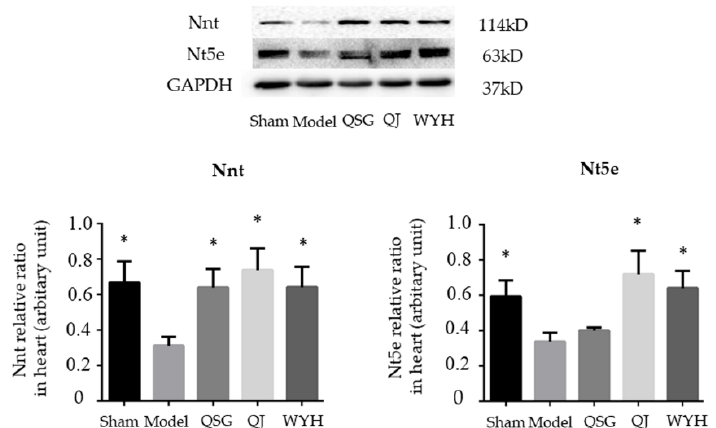
Figure 4. Western blot analysis of the Nnt and Nt5e protein levels in different treated mouse hearts. * p < 0.05 relative to the Model group. All data are presented as mean ± SE.